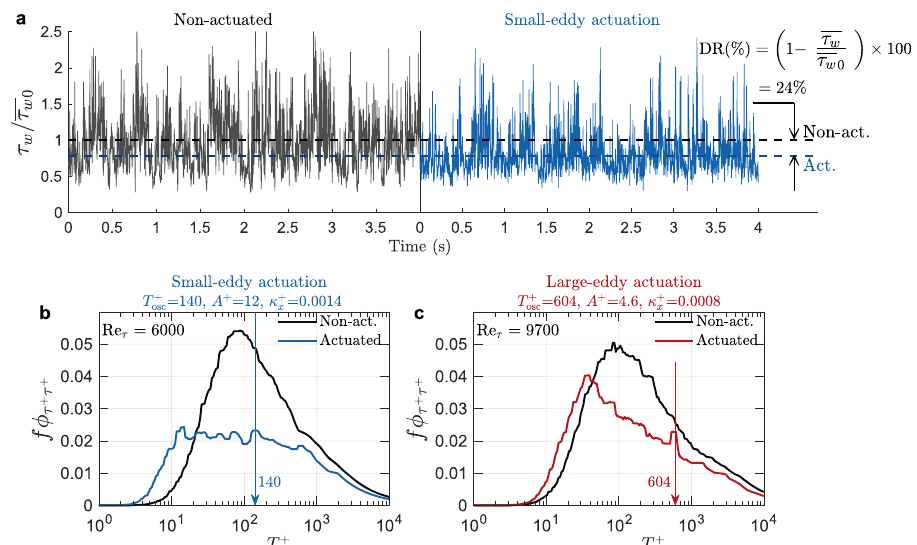
Fig. 4 Temporal fl uctuations in wall stress signals and their spectra illustrate the effects of wall actuation. a Sample of time-series measurements of the wall stress τ w at Re τ ¼ 6,000 without actuation and with small-eddy actuation ( A þ ¼ 12 ; T þ respectively. Mean values of each signal are denoted by dashed lines, whose difference indicates that the wall oscillation results in DR = 24%. b Spectra of τ w at Re τ ¼ 6,000 with and without small-eddy actuation with same parameters as in ( a ). c Spectra of τ w at Re τ ¼ 9,700 with and without large-eddy actuation